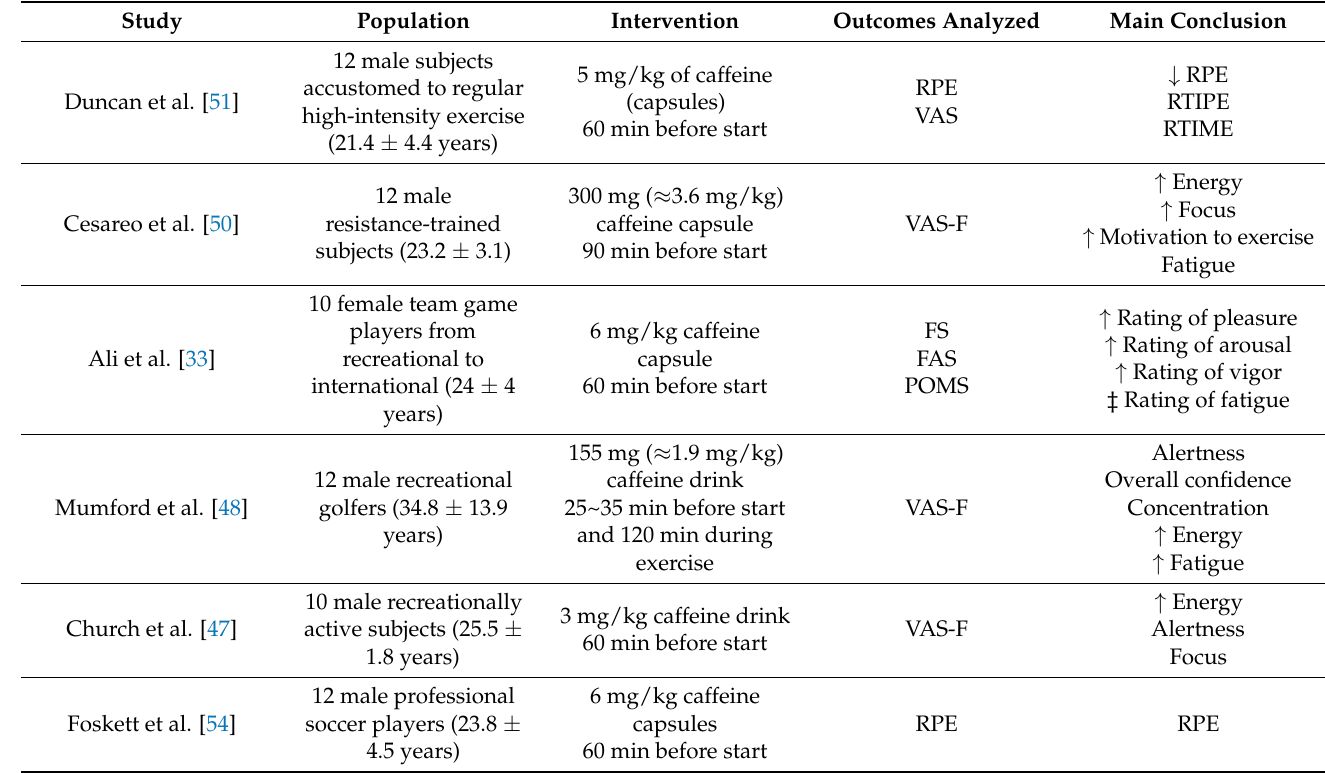
Table 6. Details and results of the studies reviewed investigating the effect of acute caffeine supplementation compared to a placebo on self-reported measures of cognitive